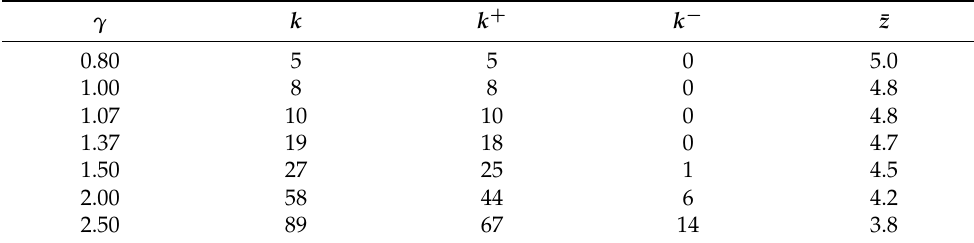
Table 3. Evaluation of topics produced from G 50 ( D BBC ) with various values of the resolution parameter γ . The table shows for each resolution the number k of topics produced. The numbers k + and k − indicate how many topics the evaluators found easy to interpret (score 5 or 4) and hard to interpret (score 1 or 2), respectively; ¯ z is the mean score of all topics of that